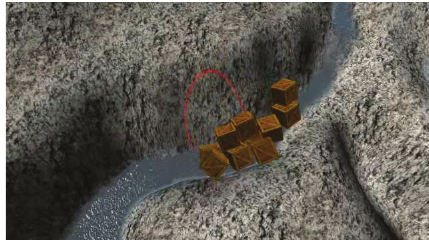
Figure 13: The same scene simulated using the method from [11], ( 𝛼 = .5 ) does not alter the river flow much.